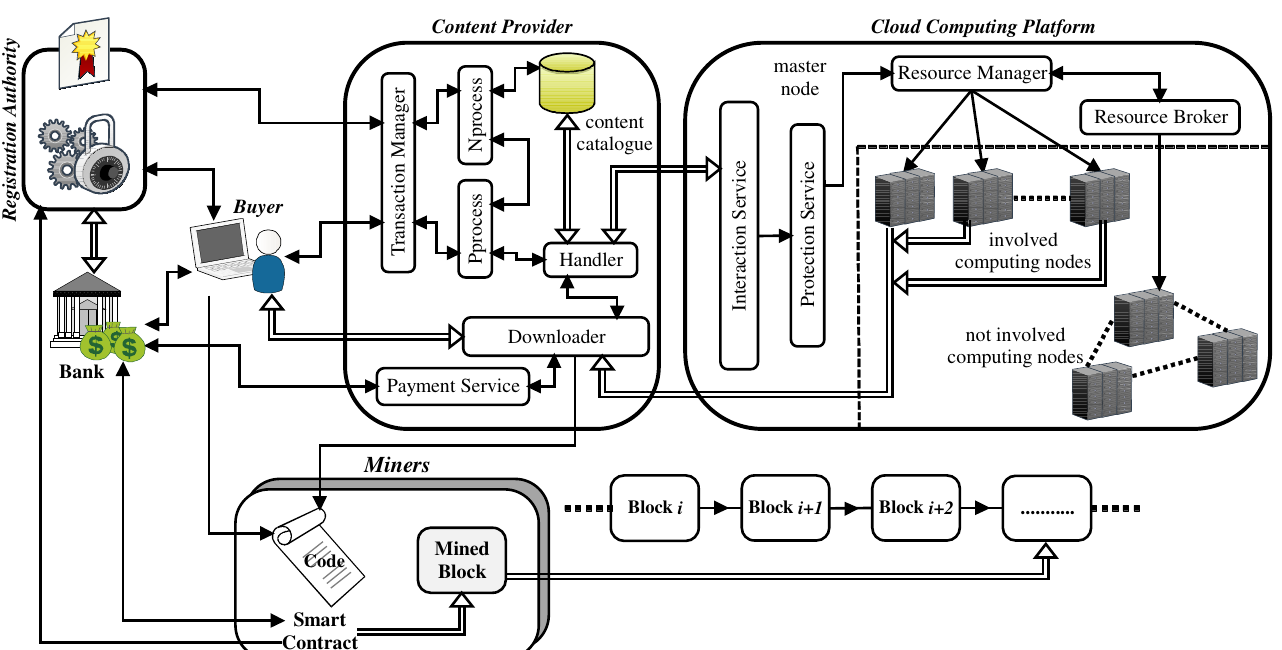
Figure 2. Prototype platform implementing the proposed watermarking